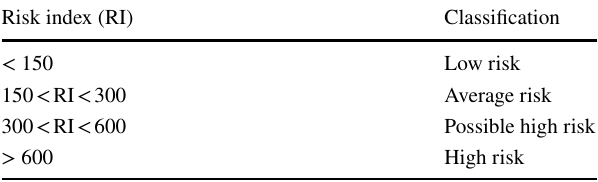
Table 3 Classification of risk index